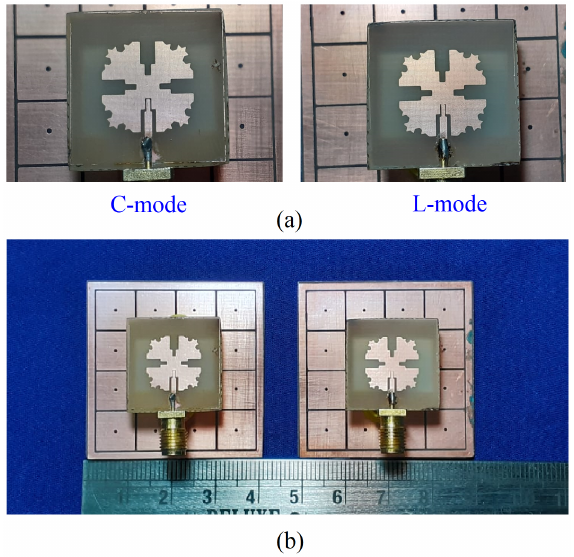
Figure 14. Fabricated antenna prototypes: ( a ) C-mode, L-mode (PCB printed top radiating layers) and ( b ) antennas with loaded dual AMC-MS layers.